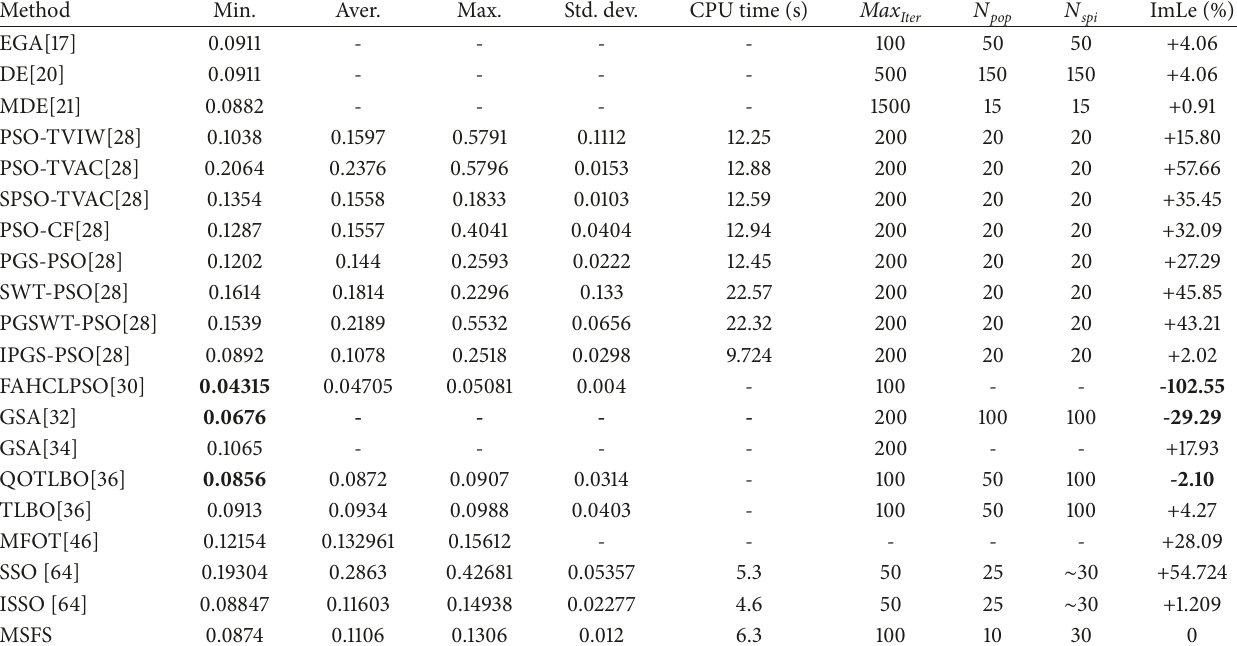
Table 6: Comparison of results obtained from IEEE 30-bus system with voltage deviation optimization.